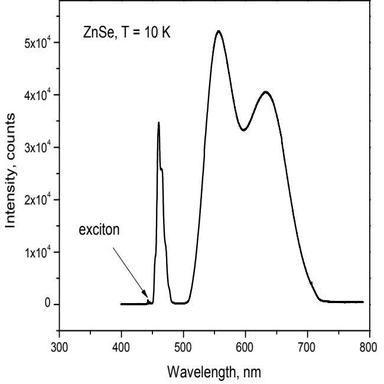
Typical emission spectrum of II-VI crystal on the example of ZnSe sample at 10 K.